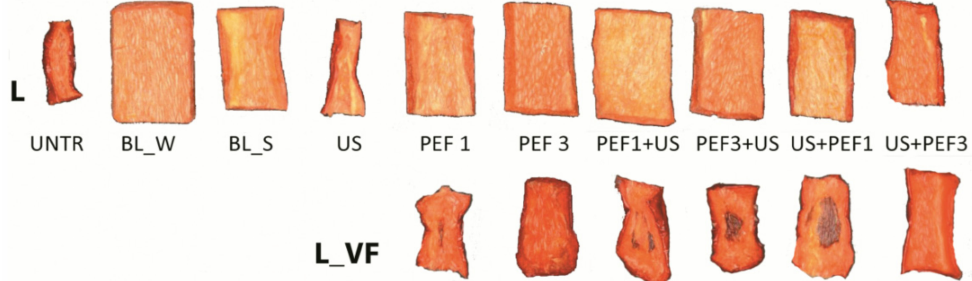
Figure 1. Photo of lyophilized red bell peppers treaded with traditional treatment (BL_W—blanching in water, BL_S—steam blanching), novel single treatment (US—sonication for 30 min, PEF_1— pulsed electric field with energy input 1 kJ/kg, PEF_3—pulsed electric field with energy input 3 kJ/kg) or novel hybrid treatment (PEF+US, US+PEF), preceded by shock freezing (L) and vacuum freezing